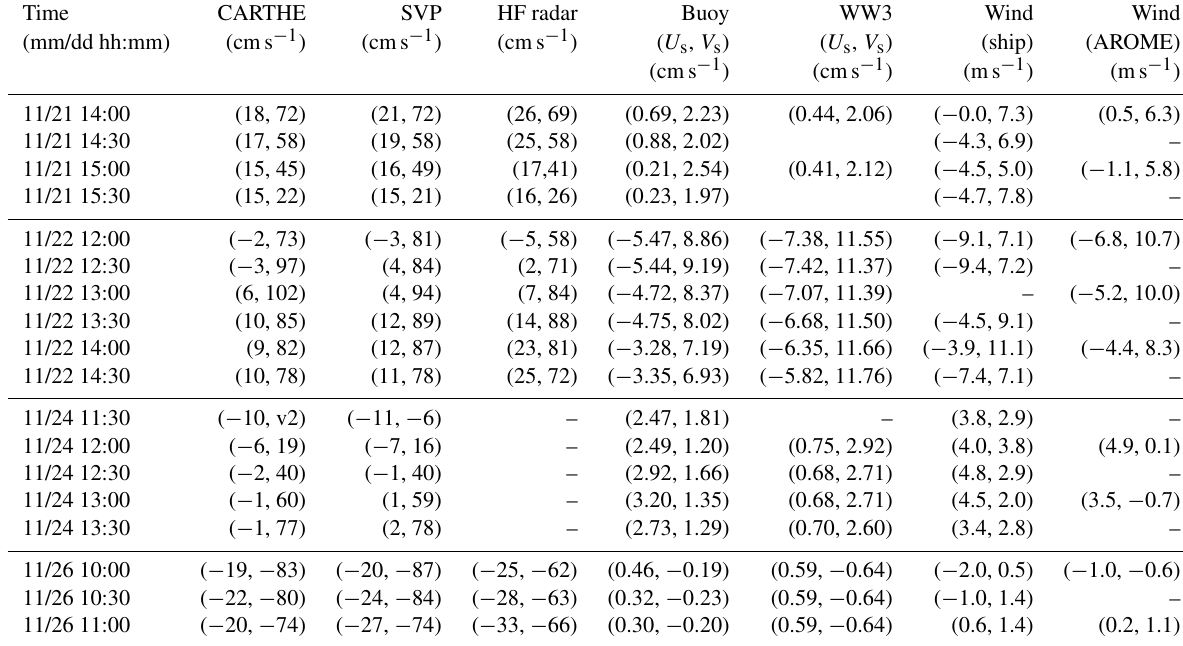
Table 3. Surface current velocity, Stokes drift and wind speed measured or estimated near position 48 ◦ 15 (cid:48) N, 5 ◦ 15 (cid:48) W. For each table entry, the parenthesized pair contains the (eastward, northward) components of the vector (cms − 1 ) for current or Stokes drift estimates and (ms − 1 ) for wind speed estimates. Please note that the Stokes drift is only integrated up to 0.5Hz. Stokes drift buoy data correspond to the Trèfle buoy for 22 November and Spotter buoy number 10 for 24